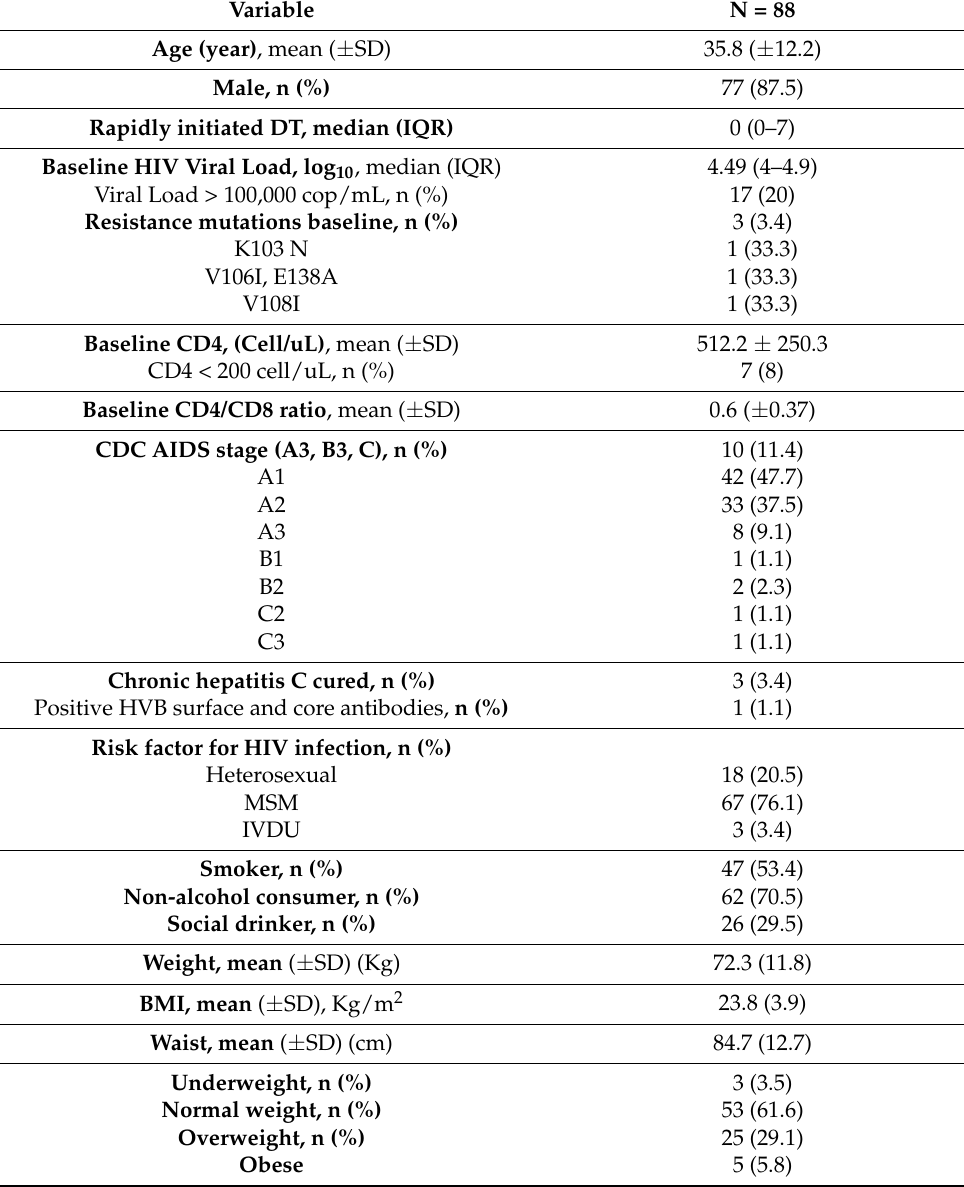
Table 1. General description of the